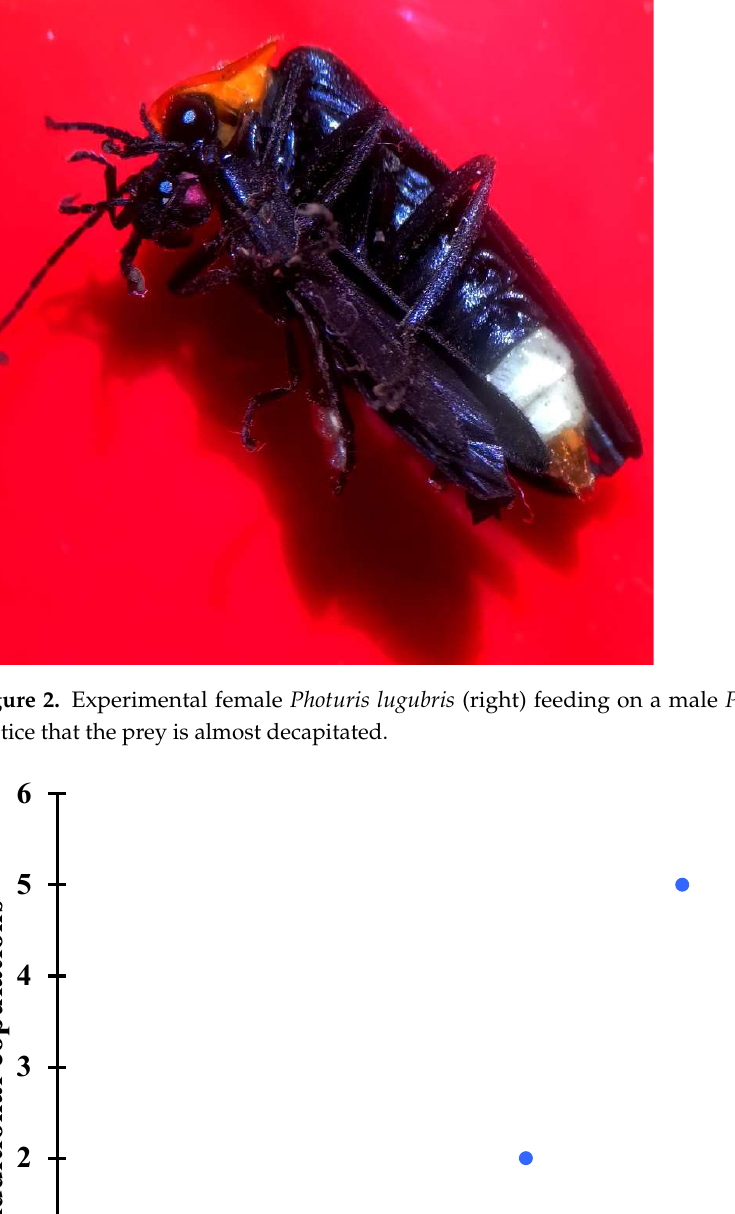
Figure 1. Number of experimental, field-collected Photuris lugubris females and males that did not attack, attack-and-ate or attack-and-lost the male Photinus palaciosi introduced to their containers.